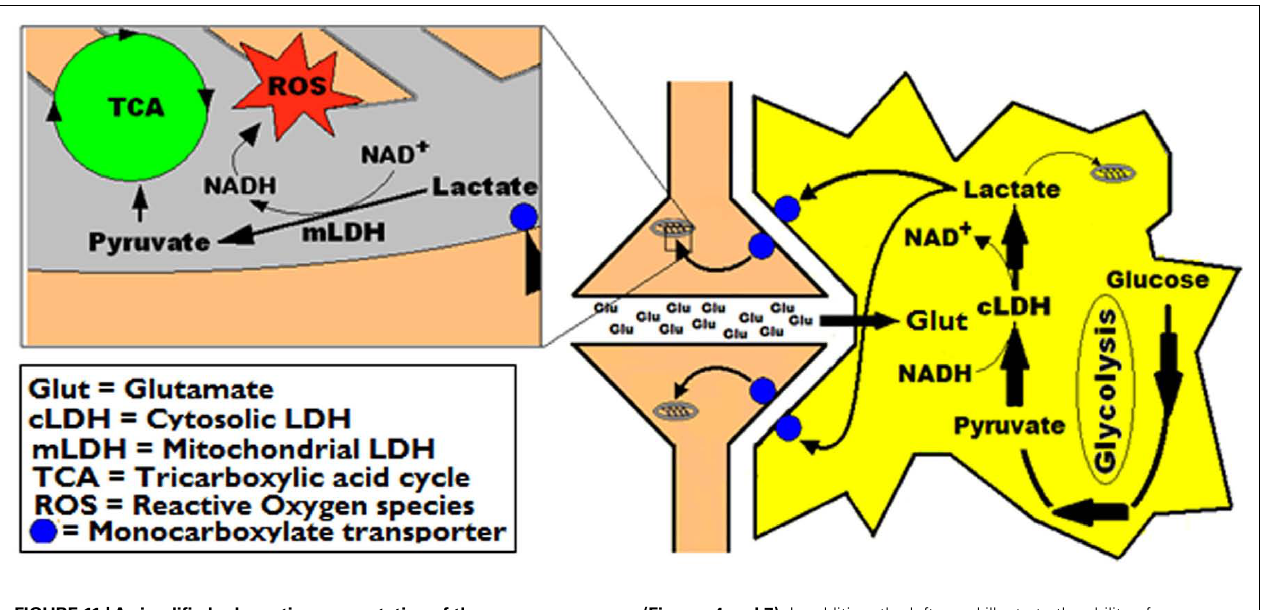
FIGURE 11 |A simplified schematic representation of the astrocytic-neuronal lactate shuttle hypothesis (ANLSH, Pellerin and Magistretti, 1994) combined with our own hypothesis that postulates lactate as the end-product of aerobic glycolysis